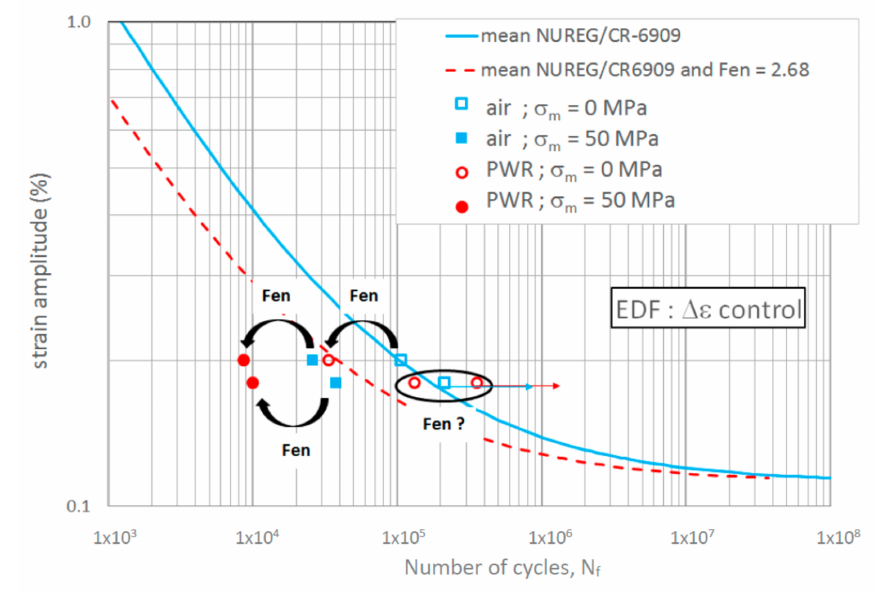
Figure 4. Strain–life data obtained from the ε -controlled